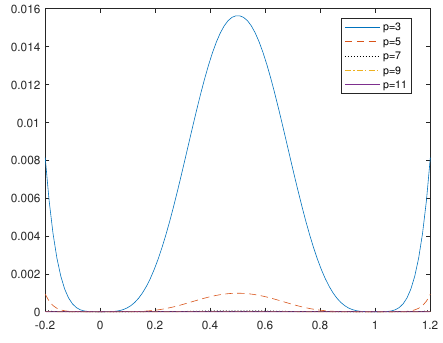
Figure 5. Graph of the function σ p